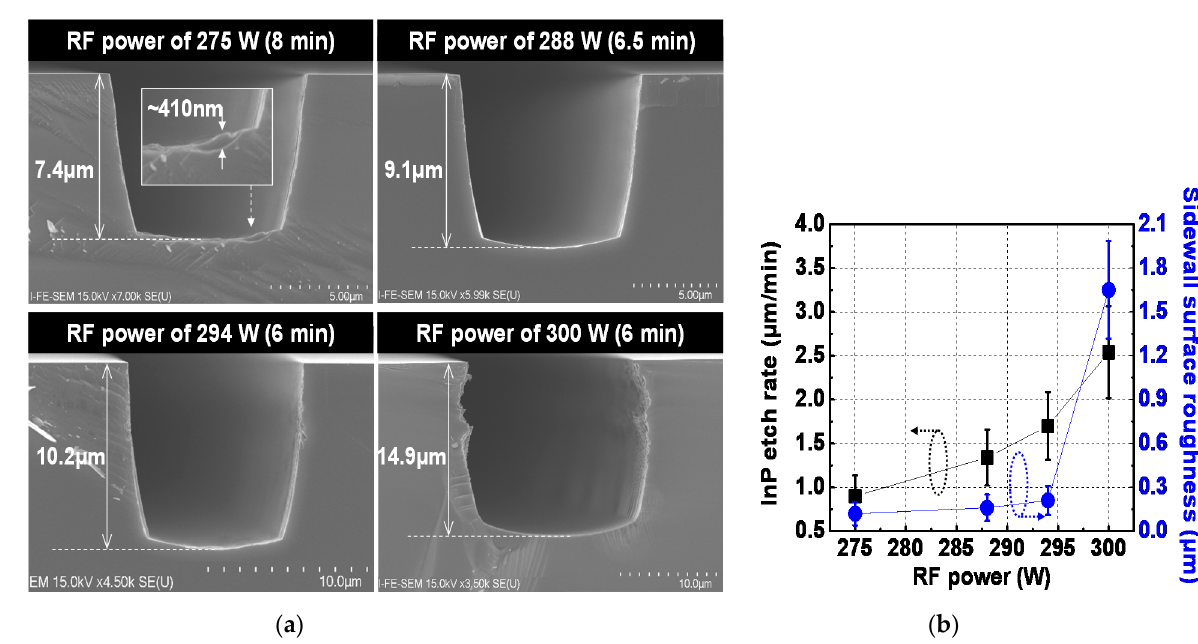
Figure 4. Fabrication results of InP via holes etched at different levels of RF power: ( a ) SEM images of representative etch profiles and ( b ) InP etch rate and sidewall surface roughness of InP via holes. Error bars in Figure 4b represent the deviation values incurred by the process variation for a total of 60 InP via holes with the same layout width in the three fabrication lots. ICP power, Cl 2 /Ar gas mixture, operation pressure, and operation temperature of the ICP etcher were 1200 W, 20/15 sccm, 5 mT and room temperature, respectively.